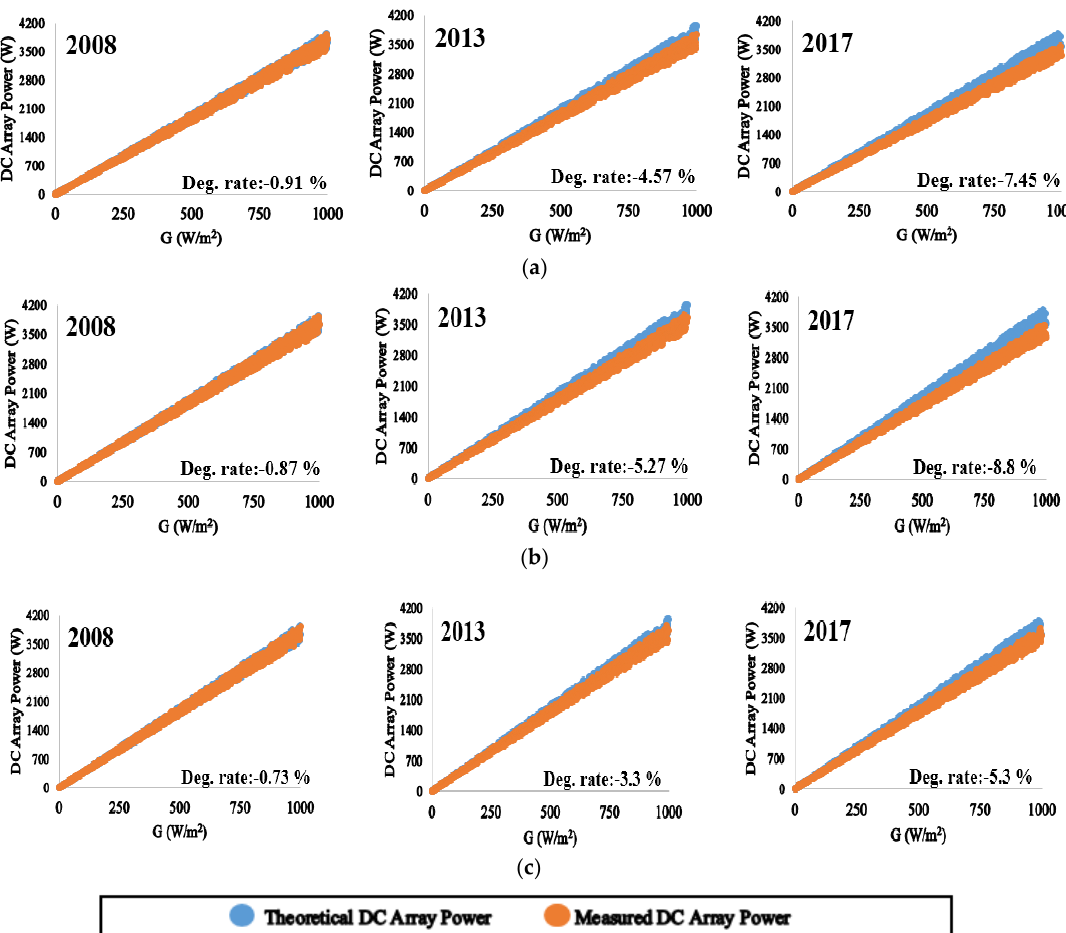
Figure 2. Cumulative degradation rates for PV systems A, B, and C in 2008, 2013, and 2017: ( a ) PV site A—Plymouth; ( b ) PV site B—London; ( c ) PV site C—Huddersfield. Table 3. England PV systems’ Degradation Rates.